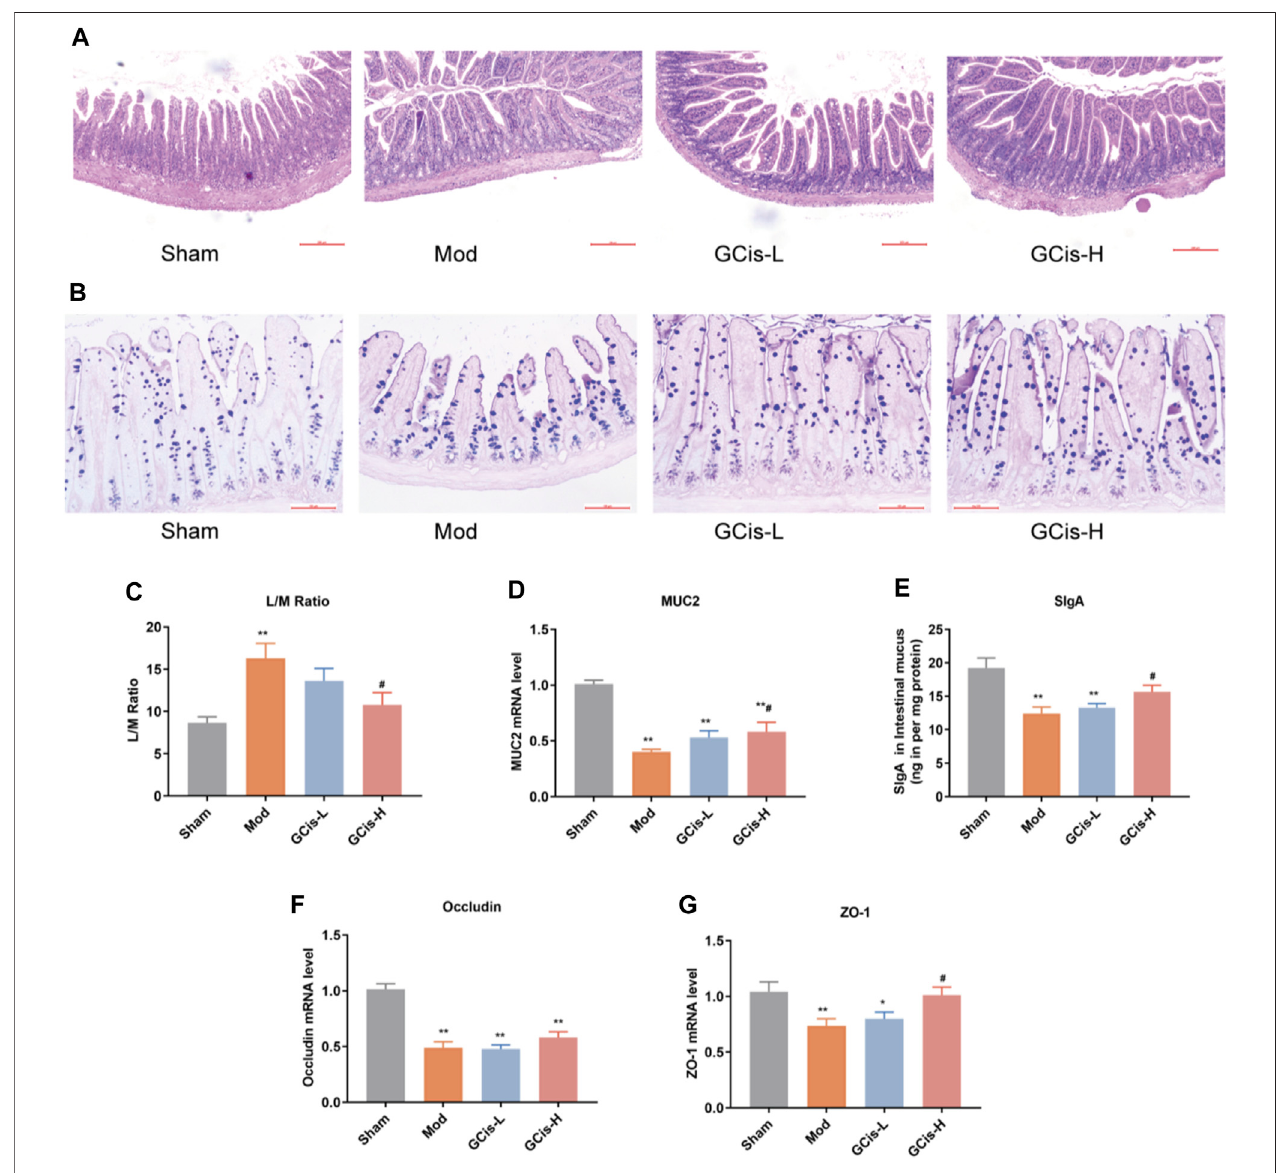
FIGURE 5 | GCis formula enhanced the intestinal barrier function. HE (A) (magni fi cation ×100) and AB-PAS (B) (magni fi cation ×200) staining of ileum tissue. (C) IntestinalpermeabilitywasevaluatedbyL/M.MUC2 (D) andSlgA (E) weredetectedbyELISA.Theexpressionofkeyindicatorsoftheintestinalmucosalbarrieroccluding (F) and ZO-1 (G) (data are shown as mean ± SEM. ** p < 0.01 compared with the sham group; # p < 0.05 compared with the model group).